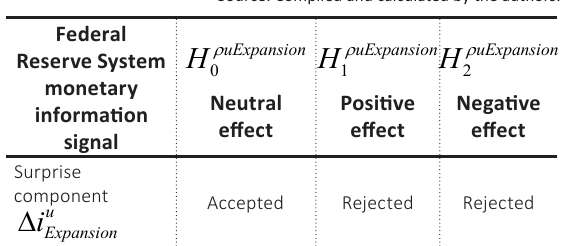
Table 10. Testing results for advanced hypotheses